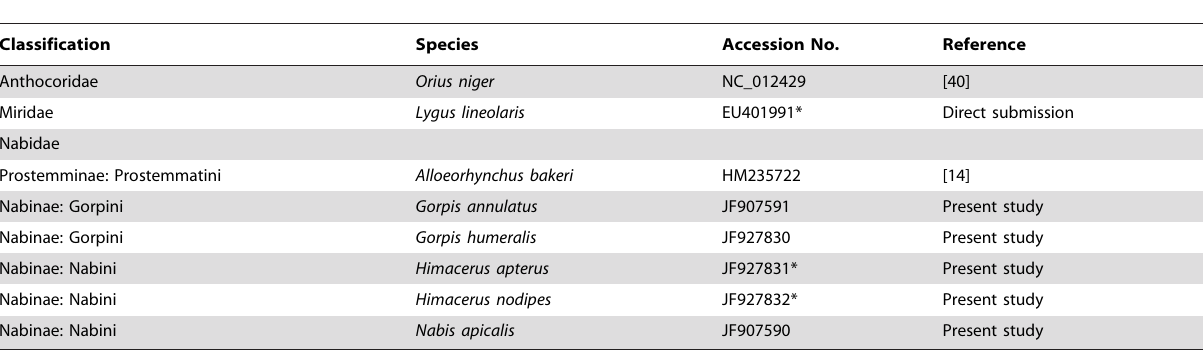
Table 1. List of the species included in the present